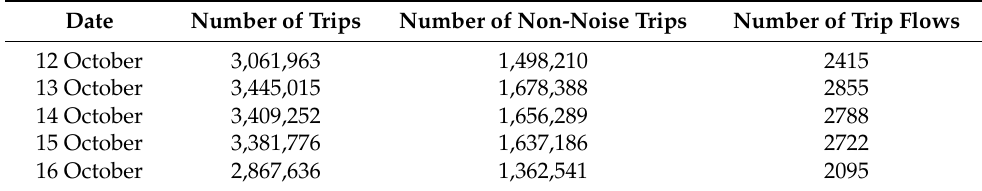
Table 1. Bus smart card data statistics.